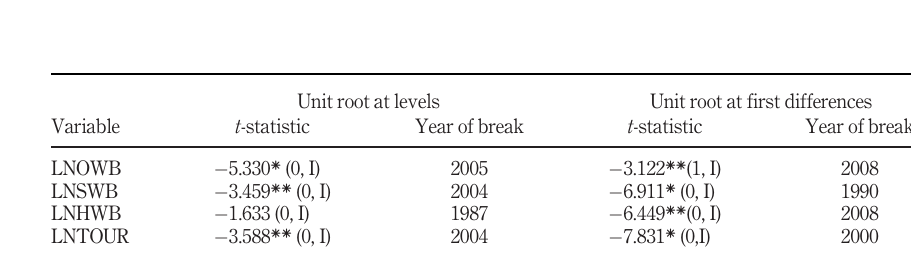
Table 5. Zivot and Andrews ’